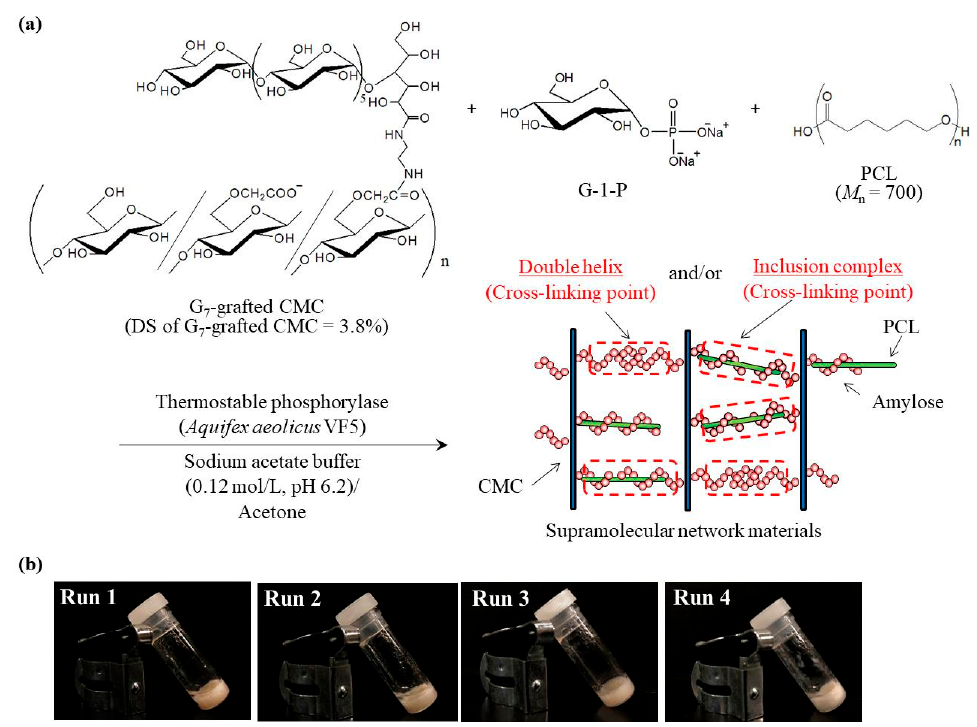
Figure 1. ( a ) Image for preparation of supramolecular network materials by means of amylose helical assemblies formed in phosphorylase-catalyzed enzymatic polymerization, and ( b ) photographs of reaction mixtures.